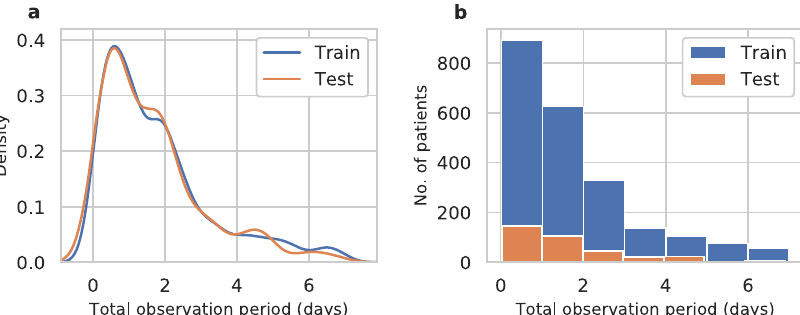
Fig. 4 Total observation period for the training and test set. a Density distribution. b Histogram. For most patients the observation period ended within three days after